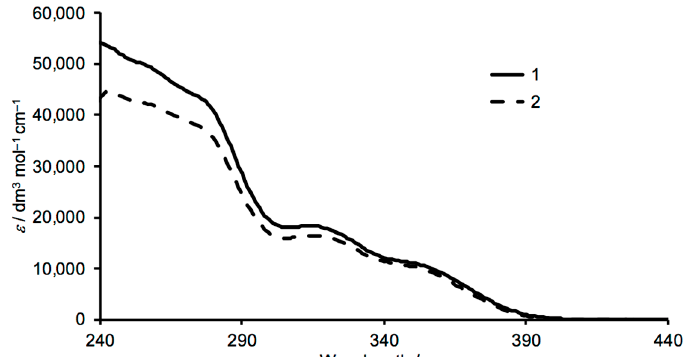
Figure 2. Solution absorption spectra of 1 and 2 in CHCl 3 (1.2 × 10 –5 mol dm –3 for 1 , 1.0 × 10 –5 mol dm –3 for 2 ).